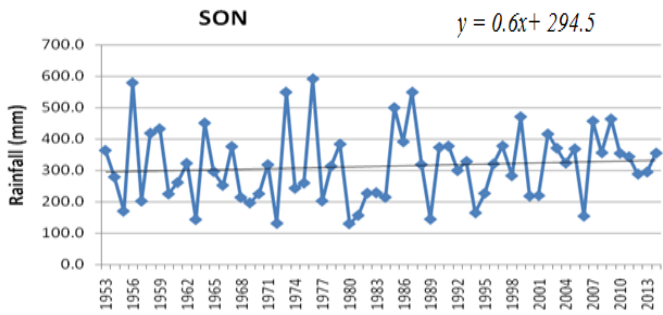
Figure 3. The time series of the September–November seasonal rainfall.